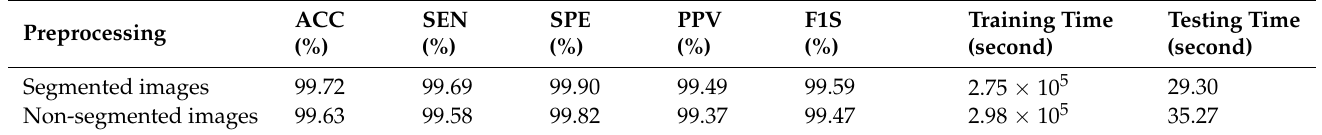
Table 6. Comparison of time for training and testing between non-segmented images and seg- mented images.